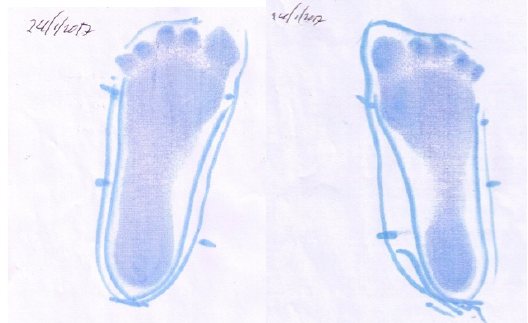
Figure 12. Participant 8 left and right final pedograph footprint (24 January 2017).